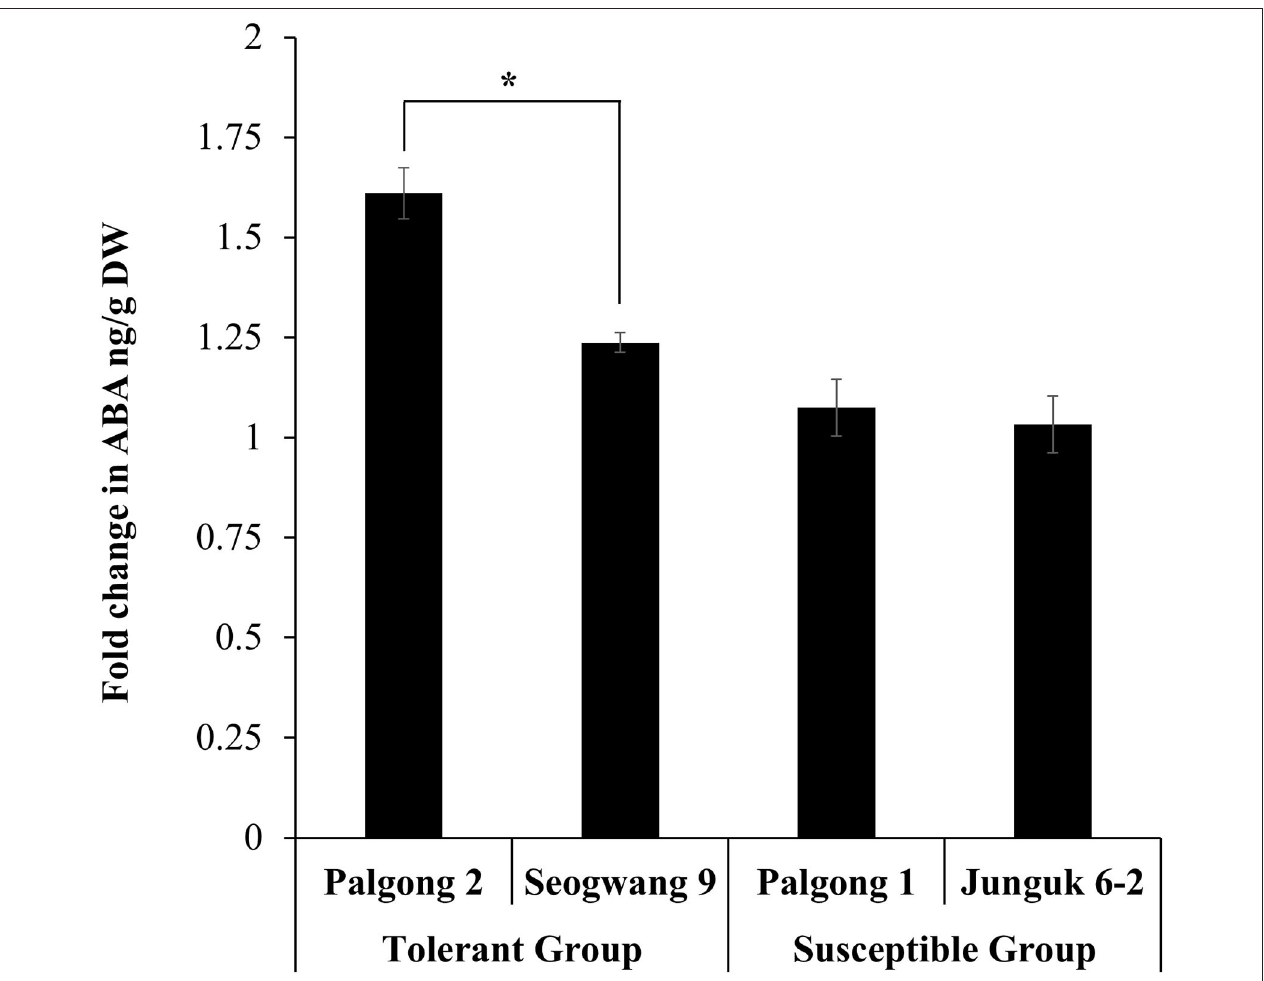
FIGURE 5 | ABA quantification in drought-tolerant and susceptible P. davidiana cultivars following dehydration stress. The abscisic acid (ABA) measurement results showed a significantly higher increase in the ABA concentration of the leaves of the drought-tolerant P. davidiana cultivars Palgong 2 and Seogwang 9 after 30min of dehydration stress as compared with the drought susceptible cultivars. Each data point represents the mean of at least three replications. Error bars represent SD. Significant differences at P < 0.05 are indicated by asterisks